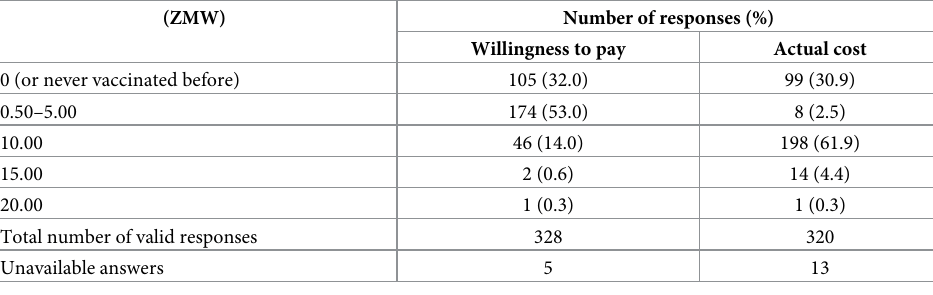
Table 8. Affordability of canine rabies